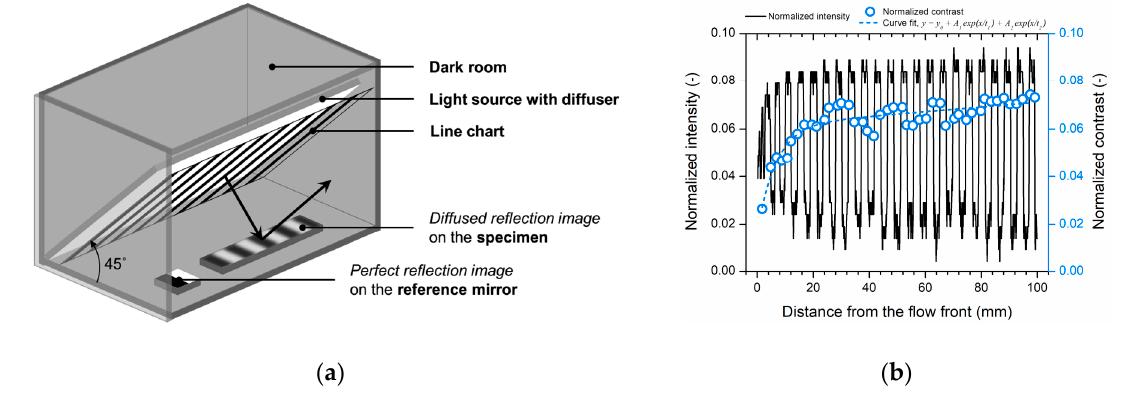
Figure 4. Gloss distribution measurement using the IPA technique [35,36]: ( a ) measurement setup and ( b ) intensity profile and contrast distribution.